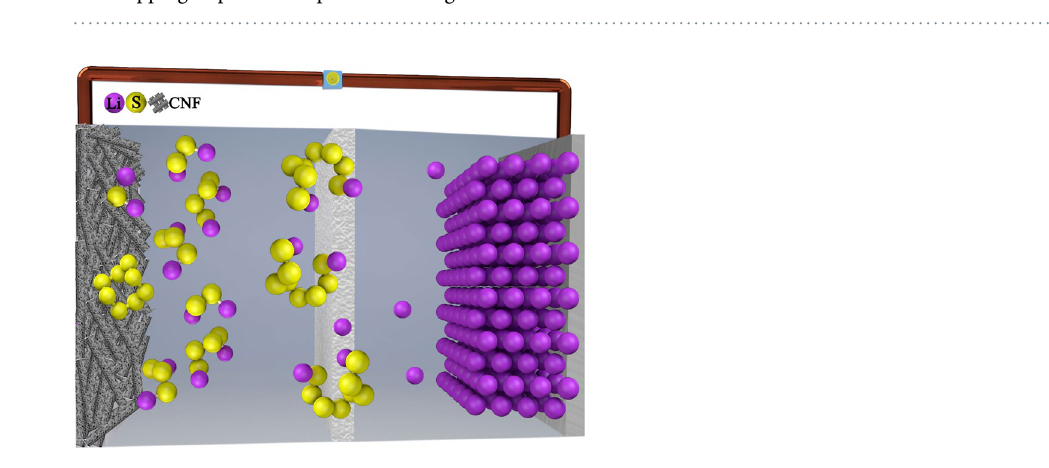
Figure 1. ( a ) Temperature dependence of the conductivity of the catholyte, TEGDME 3 -DOL 7 0.5 M Li 2 S 8 , in the temperature range − 20 °C to 70 °C. ( b ) Time evolution of the current in symmetric, Li/TEGDME 3 -DOL 7 0.5 M Li 2 S 8 /Li, cells following a DC polarization of 30 mV. Inset shows the Nyquist plots before and after the cell polarization. ( c ) Lithium stripping-deposition overvoltage of the symmetric cell cycled at a current density of 0.l mA/cm 2 with LiNO 3 added to the catholyte (see text). ( d ) Time evolution of the overall cell resistance during the stripping-deposition experiment in Fig. 1c.